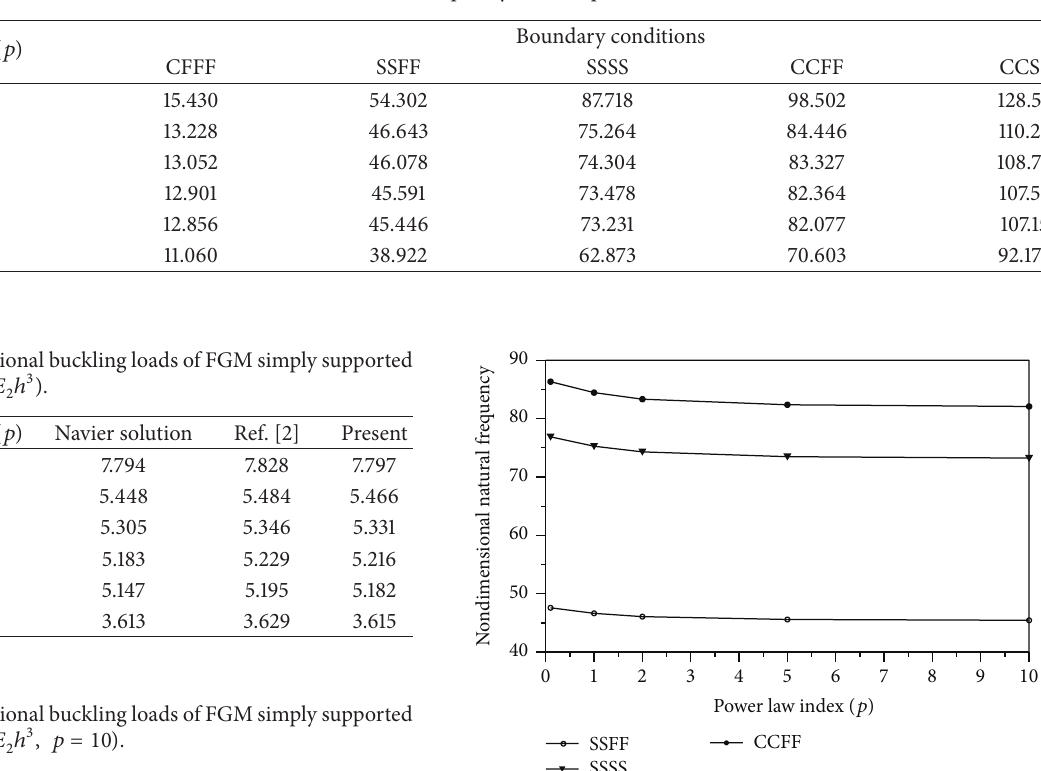
Table 6: Nondimensional natural frequency of FGM plates ( 𝑎/ℎ = 100 ).